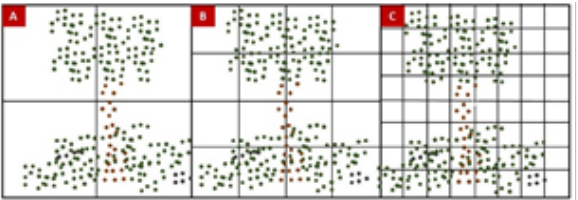
Figure 9: Significance of voxel resolution for the number of non-empty